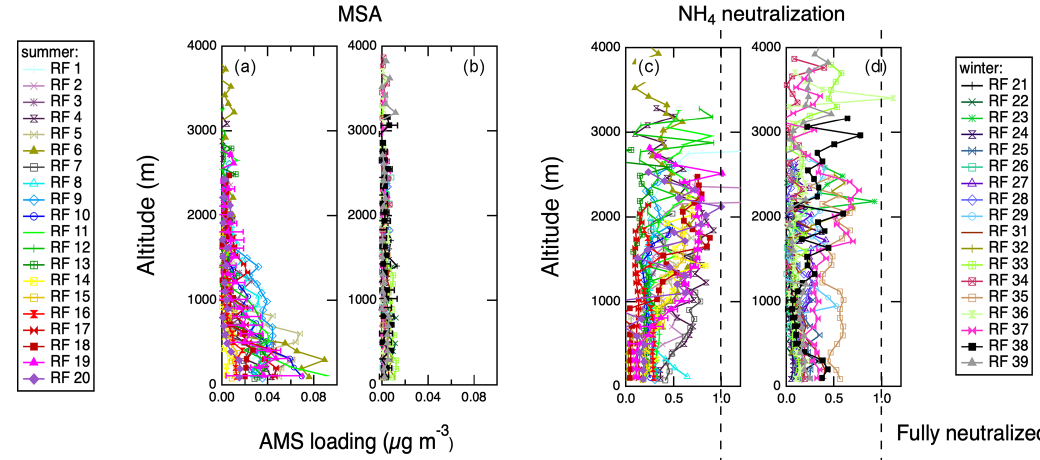
Figure 9. Vertical profiles of AMS-derived MSA and AMS-derived degree of NH 4 neutralization (a proxy for aerosol acidity) acquired during spiral profiles shown in the Supplement Fig. S1. Representative error bars (1 σ standard deviations) are shown on 1d only for